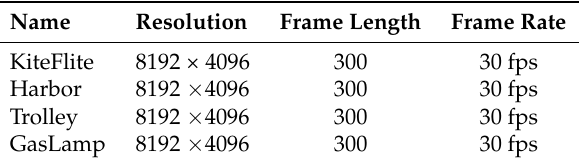
Table 3. Information of test sequences.